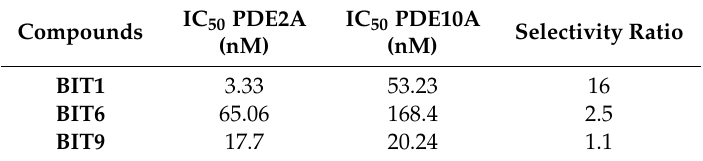
Table 4. A ffi nity and selectivity of three new fluorinated compounds towards PDE2A and PDE10A.